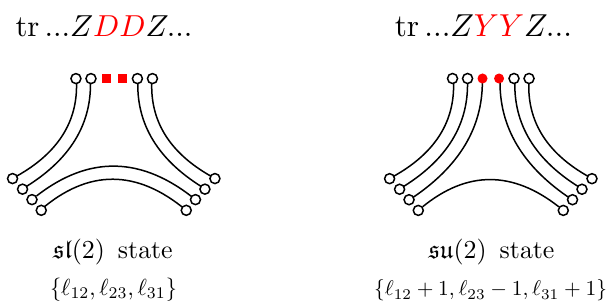
Figure 10 . The structure constants are the same for a two-derivative state or a two-scalar state, at the top of the pair of pants. The two states have di(cid:11)erent lengths and, therefore, their two structure constants exhibit di(cid:11)erent bridges. Pictorially, converting two derivatives into two scalars forces a link in the bottom bridge in the left panel to break open and reconnect with the two new spin chain sites created at the top in the right panel. It increases by one unit the lengths ‘ 12 and ‘ 31 of the adjacent bridges, at the expense of the bottom bridge that loses one unit of length. The picture ex- plains why the mirror particles propagating close to the top experience a bigger length, and are thus delayed at weak coupling, for states in the sl (2) sector. It also predicts a similar e(cid:11)ect for mirror par- ticles propagating through the bottom channel when the state at the top lies in the su (2) sector. The general lesson is that supersymmetries not only act on the state but also on the lengths of the bridges characterizing the geometry. Besides, as shown here, this action is not restricted to the bridges that are adjacent to the operator which is being transformed. A \bridges morphism" should also accom- pany the crossing transformation of excitations on geometries with (cid:12)nite bridges, since this transfor- mation, like the supersymmetric ones, comes at the cost of a length rede(cid:12)nition. These e(cid:11)ects